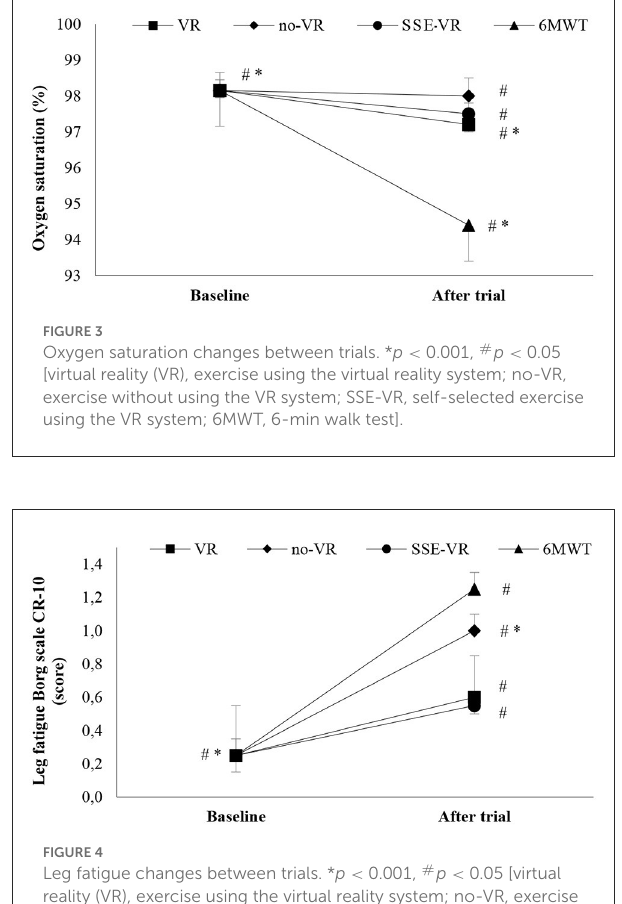
FIGURE4 Leg fatigue changes between trials. * p < 0.001, # p < 0.05 [virtual reality (VR), exercise using the virtual reality system; no-VR, exercise without using the VR system; SSE-VR, self-selected exercise using the VR system; 6MWT, 6-min walk test].